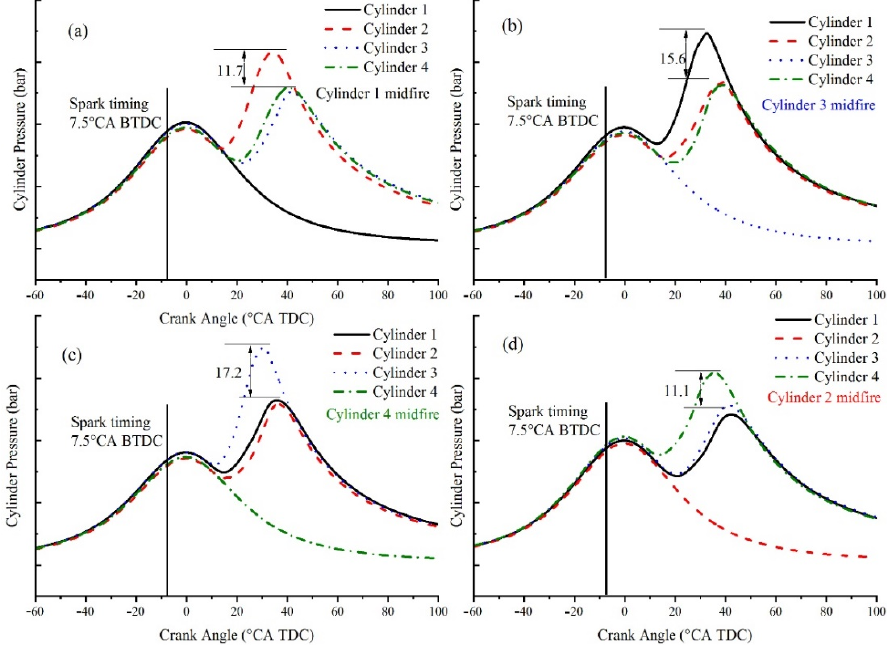
Figure 8. Abnormal combustion in the last ignition cylinder corresponding to the misfired cylinder: ( a ) misfired in cylinder 1; ( b ) misfired in cylinder 3; ( c ) misfired in cylinder 4; ( d ) misfired in cylinder 2.